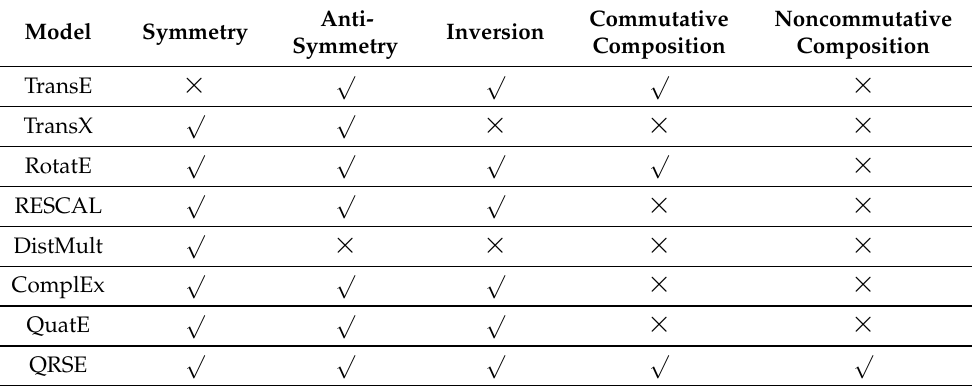
Table 2. The modeling ability comparison for various relation patterns among different models (partial reference from